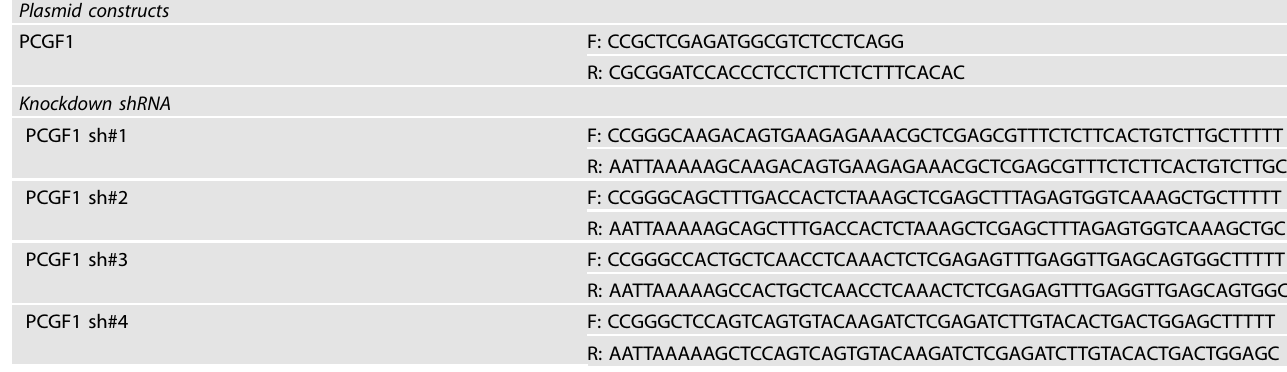
Table 2. Oligonucleotides used for plasmid